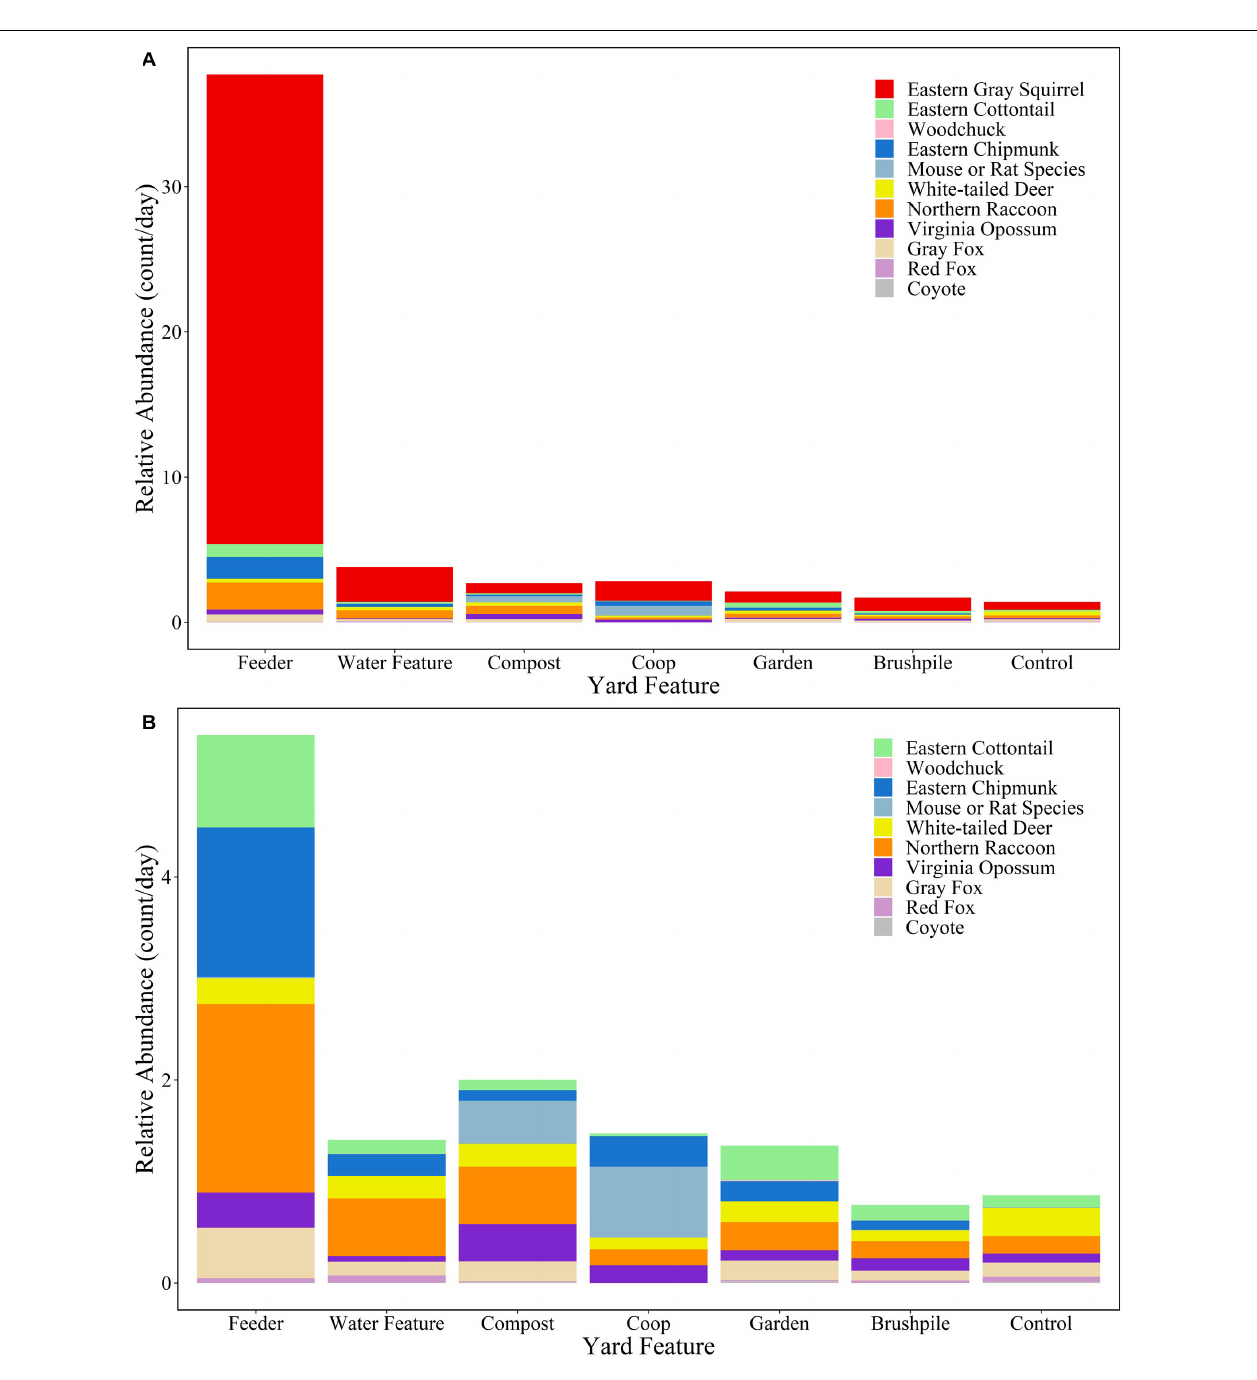
FIGURE 3 | Relative abundance (count/day) of mammal species at yard features in Raleigh, North Carolina in 2016. Figure (A) includes all species, while Figure (B) excludes eastern gray squirrels to highlight relative abundances of other species.